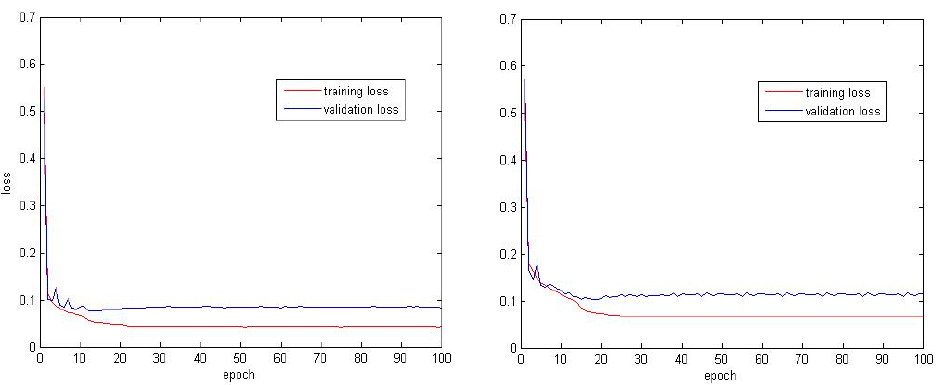
Figure 6. Training loss and validation loss of RDRCNN from two datasets. Left : Massachusetts road Figure 4. Training loss and validation loss of RDRCNN from two datasets. Left: Massachusetts road dataset. Right : GF-2 road dataset. Right: GF-2 road dataset.